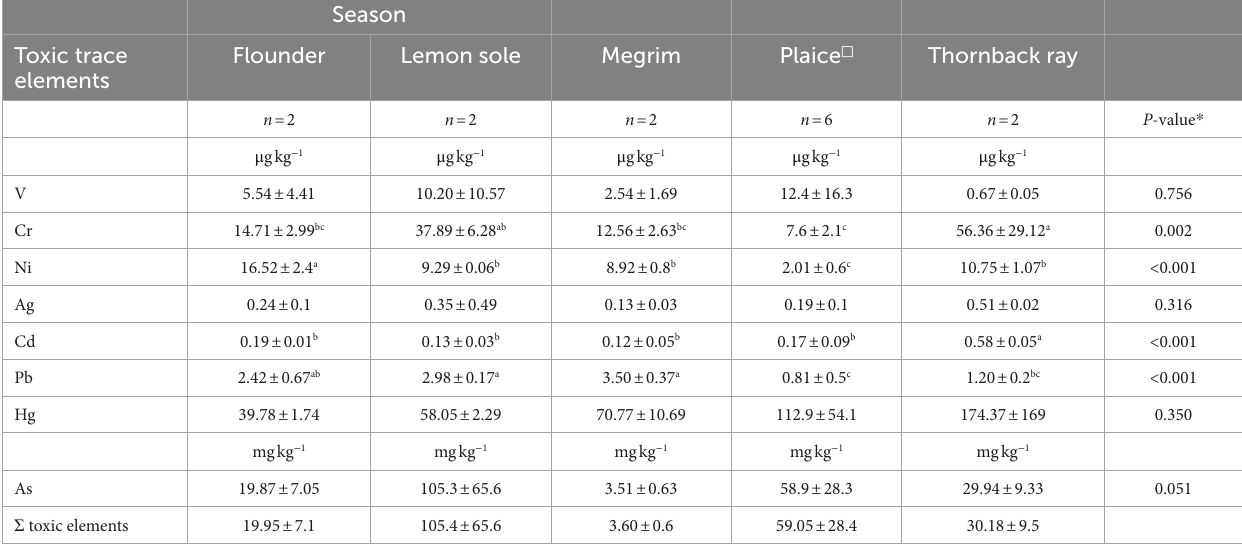
n = pooled samples constituting of multiple individuals per sample. Results presented as mean values ± SD. □ Results extracted from a previous study by Kendler et al. (21). * ANOVA was applied to detect differences in trace elements and PCBs; where significant difference was detected ( α < 0.05), a Tukey HSD post hoc test was applied. Values with different superscript ( a, b ) within a row are significantly different ( P <